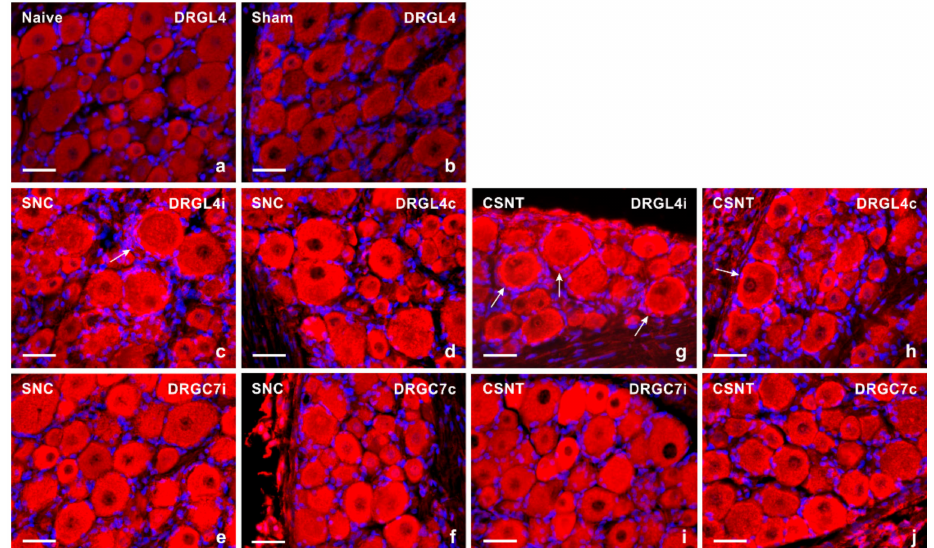
Figure 1. Representative sections of DRG from naive rat ( a ) and rats with sterile sham- ( b ), SNC- ( c – f ) or CSNT- ( g – j ) interventions for 7 days. The DRG sections of lumbar (DRG-L4) and cervical (DRG-C7) segments of both ipsilateral ( i ) and contralateral ( c ) sides were immunostained for TLR9 using a rabbit polyclonal antibody and donkey TRITC-conjugated anti-rabbit secondary antibody under the same conditions. Besides neuronal bodies, increased TLR9 immunofluorescence was found in satellite glial cells enveloping the neuronal bodies of ipsilateral DRG-L4 after SNC (arrow in Figure 1c) and bilaterally in DRG-L4 after CSNT (arrows in Figure 1g,h). Scale bars = 40 µ